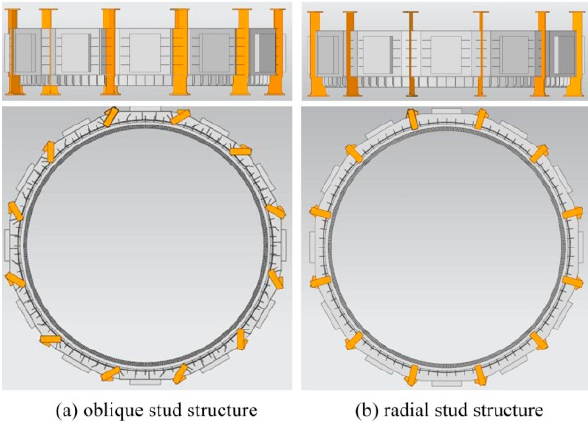
Figure 18. Models of oblique-stud structure and radial-stud structure.